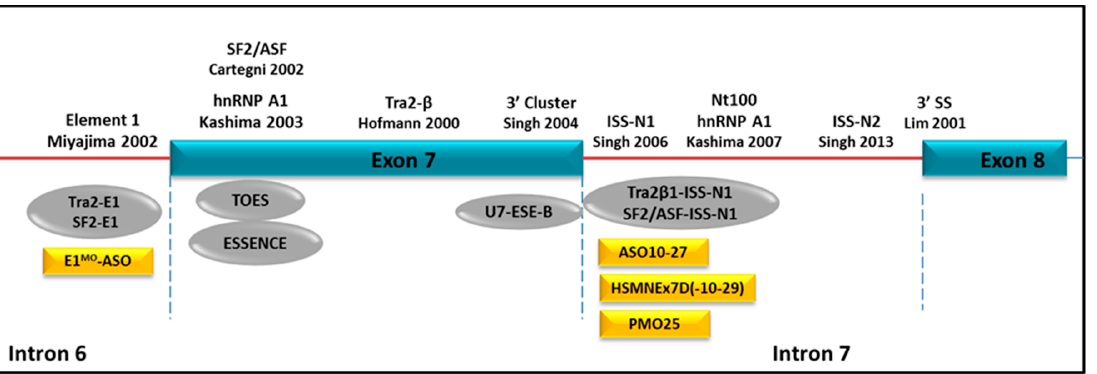
Figure 3. DMD antisense oligonucleotides in clinical trials. Data extrapolated from https://clinicaltrials. gov February 2017.